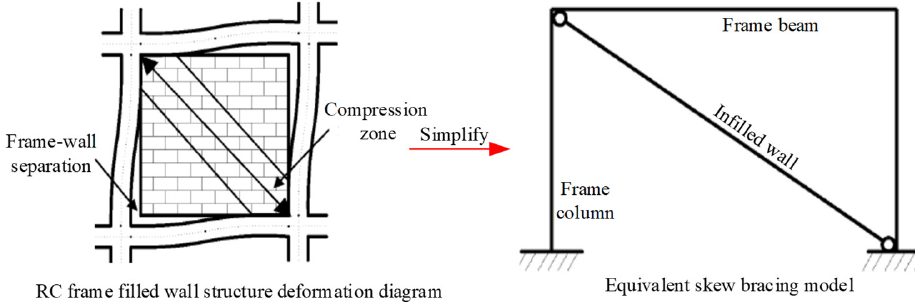
Figure 2. Structural mechanical model of RC frame infilled wall under horizontal load [19].